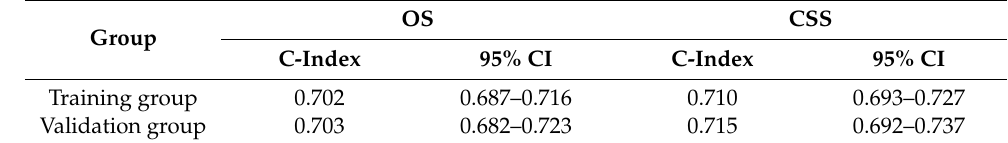
Table 4. The C-indices for predictions of OS and